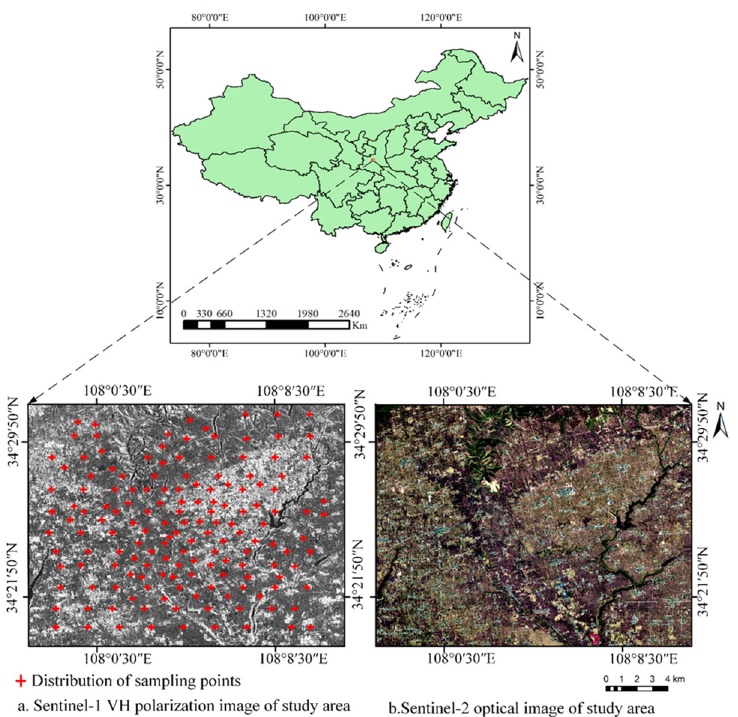
Figure 3. The location of the study area, shown as a Sentinel-1A SAR image from March 2018 ( a ) and the Sentinel-2A optical image from March 2018 ( b ).